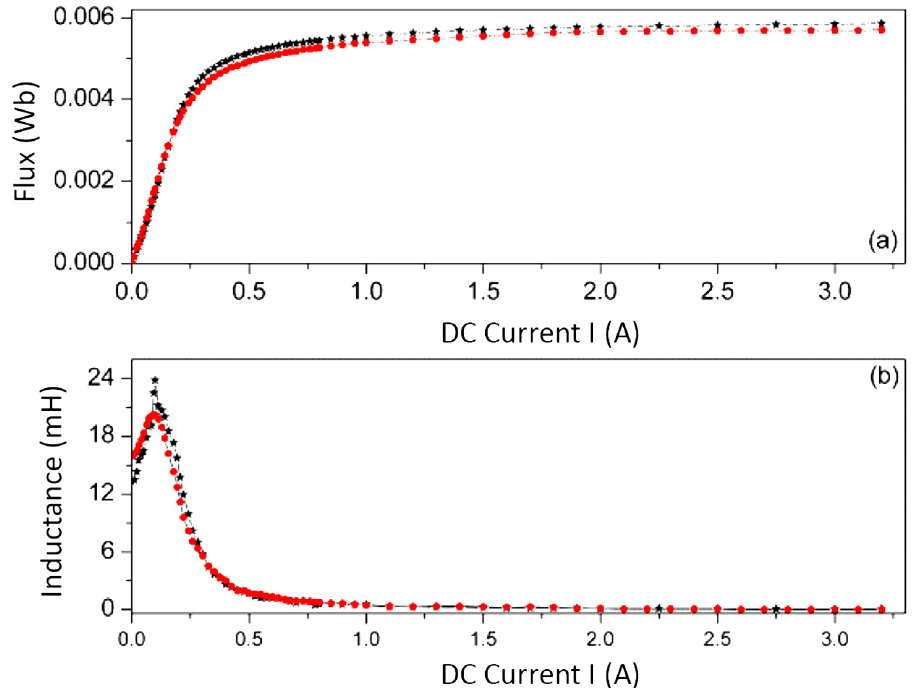
Figure 13. Results for the E65/32/27 ferrite core. ( a ) Φ - I curves and ( b ) L - I curves. Experiment (– * –) and 2D simulations (–  –) with g = 0